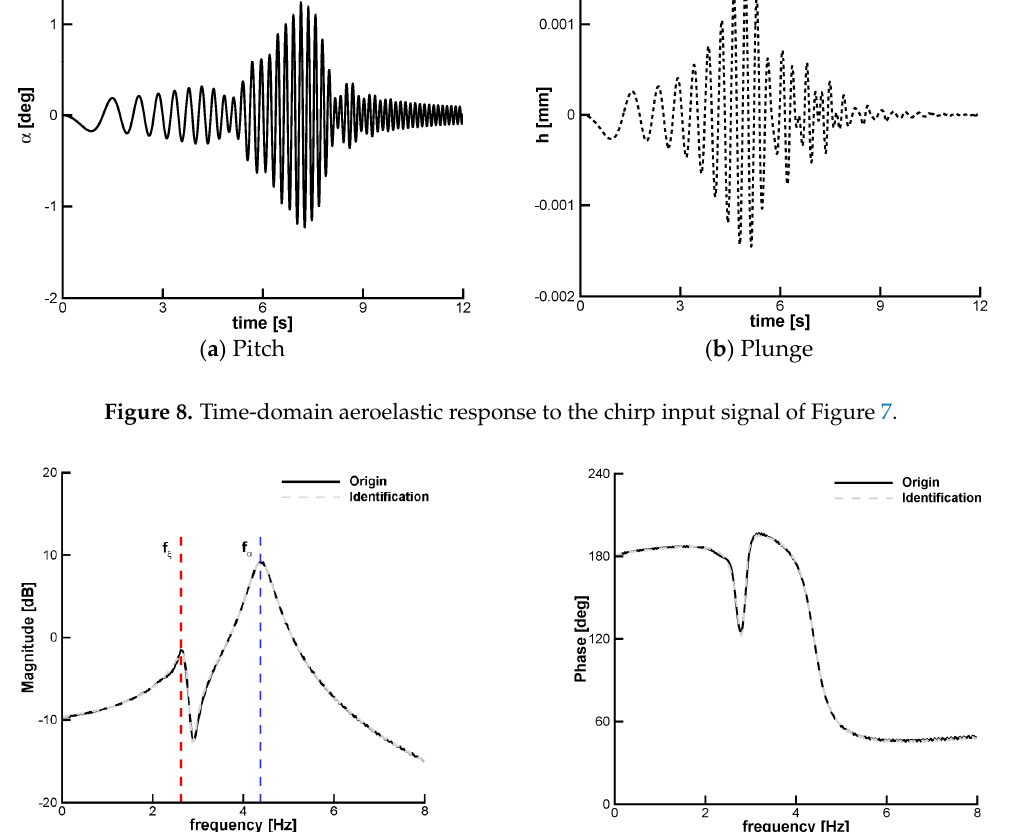
Table 2. Identified transfer function of the single-input single-output (SISO) system.